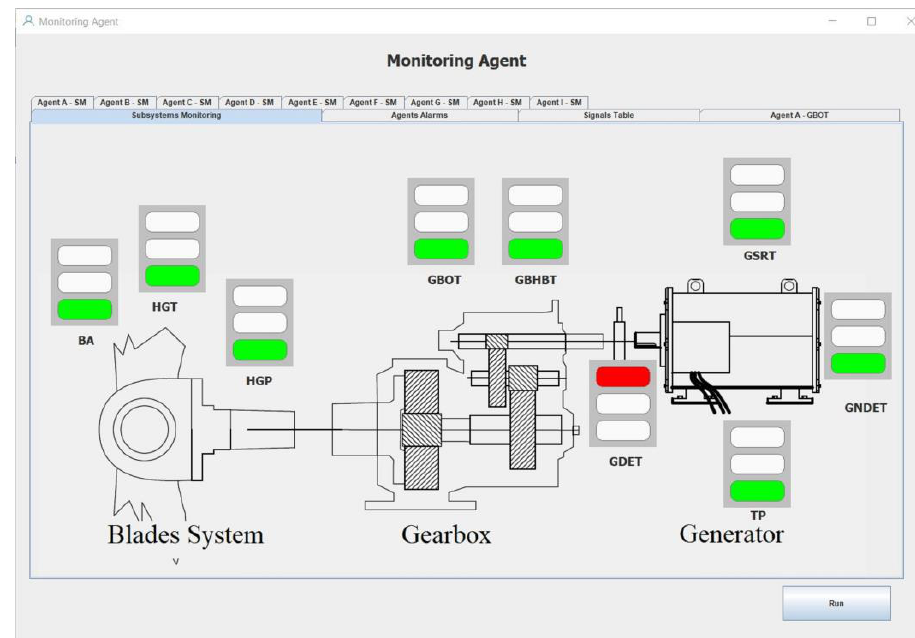
Figure 10. Monitoring and synchronizing agent.